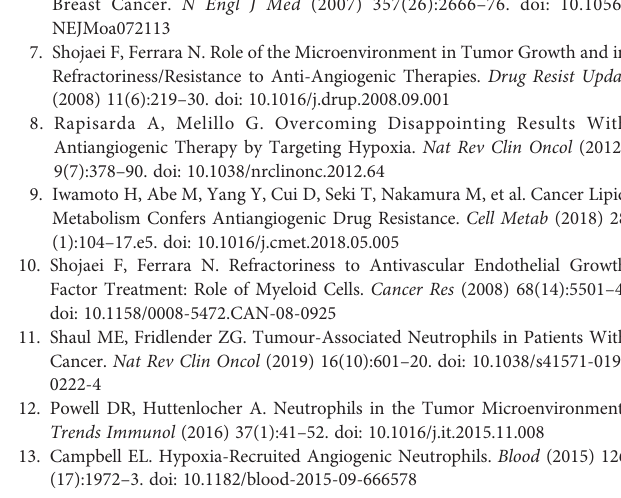
Supplementary Figure S4 | related to Figure 4 . (A) Giemsa-stained naive BM- derived neutrophils treated with different concentrations of VEGFR2-TKI in vitro . (B) Flow cytometry analysis of ROS expression of neutrophils treated with different concentrations of VEGFR2-TKI in vitro . (C) Giemsa-stained naive BM-derived neutrophils without any treatment. (D) Giemsa-stained neutrophils treated with or without IL17A mAb or IFN- g mAb. Data are presented as the means ± SD from one representative experiment. Similar results were obtained from three independent experiments, n=4 mice each group, unless indicated otherwise. Statistical analysis was performed by one-way ANOVA. ns, not signi fi cant, *p<0.05, **p<0.01, and ***p<0.001. Supplementary Figure S5 | related to Figure 5 . (A) Flow cytometry gating strategy of tumor cells. (B) Frequency of PD-L1 expression on tumor cells (CD45 - EpCAM + )inthetumorafterVEGFR2-TKItherapy.Dataarepresentedasthemeans± SD from one representative experiment. Similar results were obtained from three independent experiments, n=4 mice each group, unless indicated otherwise. Statistical analysis was performed by one-way ANOVA. ns, not signi fi cant, *p<0.05, **p<0.01, and ***p<0.001. Supplementary Figure S6 | related to Figure 6 . (A) Compared biochemical parameters associated with immunosuppressive characterization of neutrophils including arginase (Functional kit), NO (Content detection kit) and PGE2 (ELISA) in tumor-in fi ltrating neutrophils after different dose of VEGFR2-TKI therapies. (B, C) Flow cytometry analysis of proliferation (B) and PD-1 expression (C) of CD8 + T cells after co-culturing with the different group of gd T cells sorting from the tumor after VEGFR2-TKI therapy. CD8 + T cells were derived from naive spleen. (D, E) Flow cytometry analysis of proliferation of CD8 + T cells (CFSE low CD8 + ) (D) and PD-1 expression of CD8 + T cells (E) treated with different concentrations of VEGFR2-TKI in vitro . Data are presented as the means ± SD from one representative experiment. Similar results were obtained from three independent experiments, n=4 mice each group, unless indicated otherwise. Statistical analysis was performed by one-way ANOVA. ns, not signi fi cant, *p<0.05, **p<0.01, and ***p<0.001. Supplementary Figure S7 | related to Figure 7 . (A) Flow cytometry analysis of neutrophils in the PB of the 4T1 model treated with Ly-6G mAb. (B) Representative of primary tumor after high-dose VEGFR2-TKI therapy and(or) IL17A mAb, PD-1 mAborLy6GmAb. (C) H&Estainingandquanti fi cationoflungmetastasisinthe4T1 model(Blackarrow)aftermultipletreatments.Bar=1mm.Dataarepresented asthe means±SDfromonerepresentativeexperiment. Similarresultswereobtainedfrom three independent experiments, n=4 mice each group, unless indicated otherwise. Statistical analysis was performed by one-way ANOVA. ns, not signi fi cant, *p<0.05, **p<0.01, and